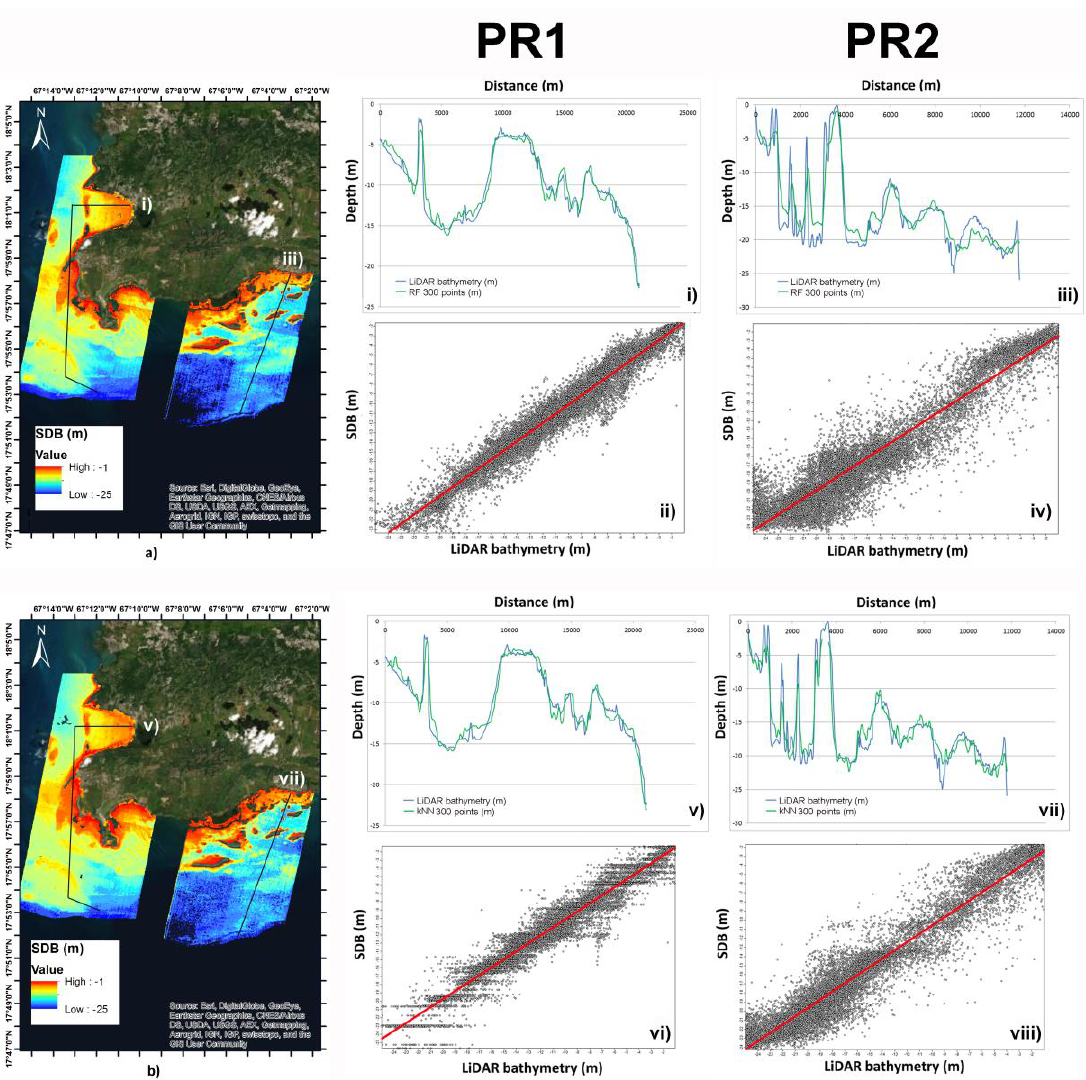
Figure 6. Satellite-derived bathymetry from stage 2 using ( a ) the RF algorithm and ( b ) the kNN algorithm. PR1: Bathymetric profile comparison and scatterplot between airborne laser bathymetry and stage 2 SDB using RF (i,ii) and kNN (v,vi). PR2: Bathymetric profile comparison and scatterplot between airborne laser bathymetry and stage 2 SDB using RF (iii,iv) and kNN